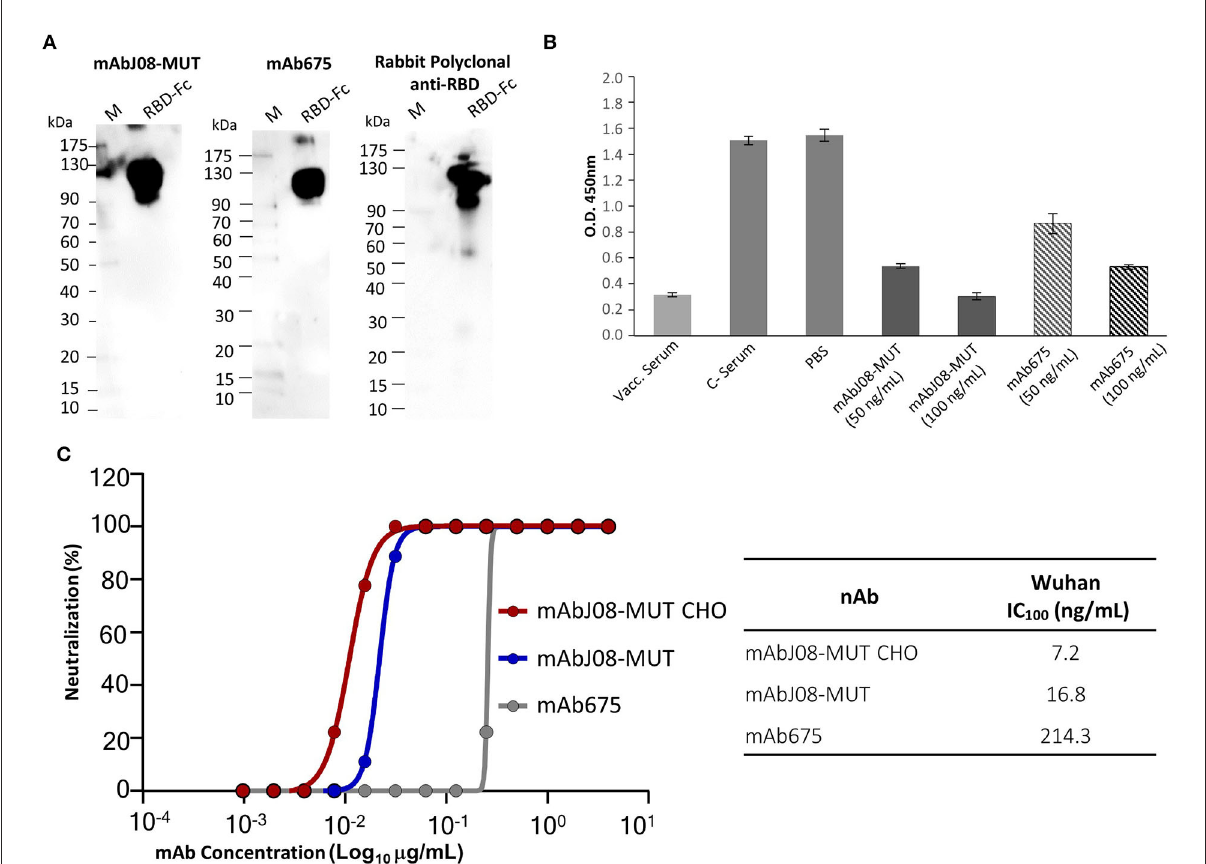
FIGURE5 RBD recognition, RBD-binding competition with ACE2, and neutralization activity against SARS-CoV-2 of the plant-derived antibodies. (A) The plant-purified mAb675 and mAbJ08-MUT were assayed for binding to recombinant RBD in the Western blotting experiments. A commercial RBD fusion protein (25 ng) produced in HEK293 cells was separated on non-reducing 12% SDS-PAGE and assayed with both antibodies at a dilution of 200ng/mL; C + : Commercial rabbit anti-RBD polyclonal antibodies were used as a control. (B) A competitive ELISA was used to assay the capacity of plant-produced nAbs to compete for the binding of ACE2 to RBD. The plate was coated with a SARS-CoV-2 RBD antigen. Samples with neutralizing antibodies were incubated with excess amounts of biotinylated ACE2, and any ACE2 bound to the RBD was assayed with Streptavidin-HRP conjugate antibody. Both nAbs were assayed at a concentration of 100 and 50ng/mL; a serum sample from a vaccinated individual at 1:50 dilution was also assayed, together with pre-vaccine serum (C-) and PBS. Values are the mean ± SD ( n = 3); Unpaired two-tailed Student’s t -test, p = 0.0001 for mAbJ08-MUT 50 ng, mAbJ08-MUT 100 ng, and mAb675 100 ng vs. both C– Serum and PBS. P = 0.0007 and P = 0.0002 for mAb675 50 ng vs. PBS and C– Serum, respectively. (C) The neutralization curve for the plant-produced antibodies as well as the mAbJ08-MUT CHO produced in a mammalian cell line was calculated, and the percentage of viral neutralization against the authentic SARS-CoV-2 wild type as obtained for different mAb concentrations is reported. The calculated 100% inhibitory concentration (IC100) for the three nAbs is also shown for